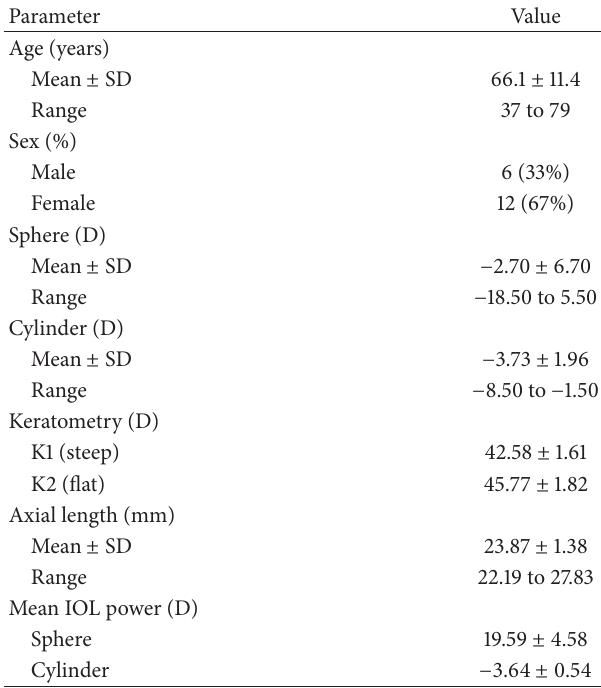
Table1:Patientdemographicsandpreoperativedataintheanalyzed